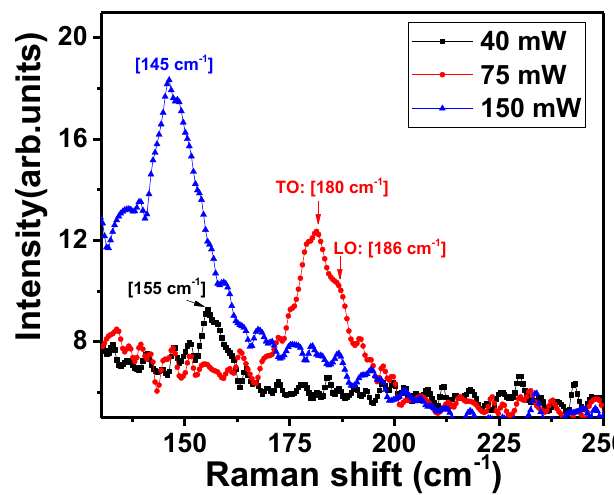
Figure 6. Comparison of Raman spectrum of a single a - InSb NWs, measured with increasing laser power on the sample. The laser power was varied from 40 mW to 150 mW. At 40 mW, the broad peak around ∼ 155 cm − 1 is attributed to homopolar Sb - Sb bonds in a - InSb . Increasing laser power (75 mW), causes localized crystallization of the NW, resulting in characteristic crystalline peaks measured at 181 cm − 1 and at 186 cm − 1 . Further increase in the laser power results in reverting the material back to its amorphous sate. This is evident in the disappearance of the crystalline peaks and the emergence of the broad peak around ∼ 145 cm − 1